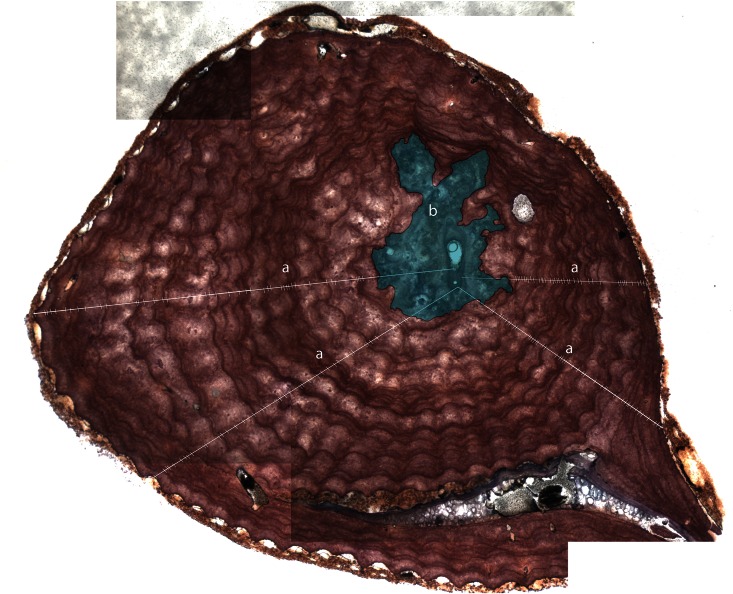
Section of a Corallium rubrum colony after decalcification and staining [38].a) Lines corresponding to counting transects. Each dash indicates a circular ring and corresponds to a year. b) Medullar region. Image composed by five high-resolution photographs. This colony has an estimated age of 43.4 (± 5.37) years.